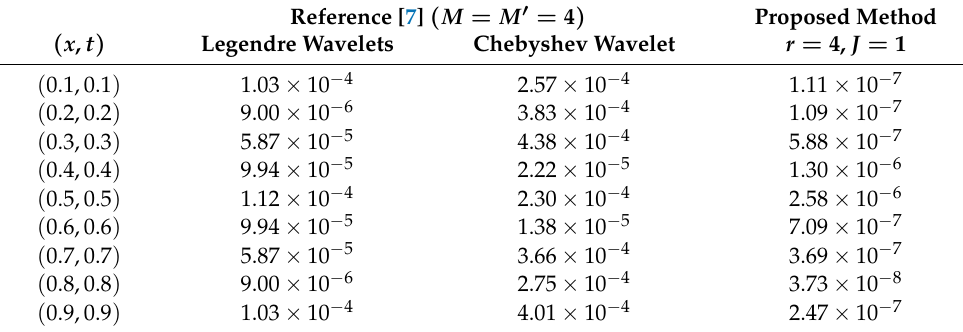
Table 7. Absolute values of the error at the selected points taking θ = 1/2 and δ t = 0.1/2 9 for Example